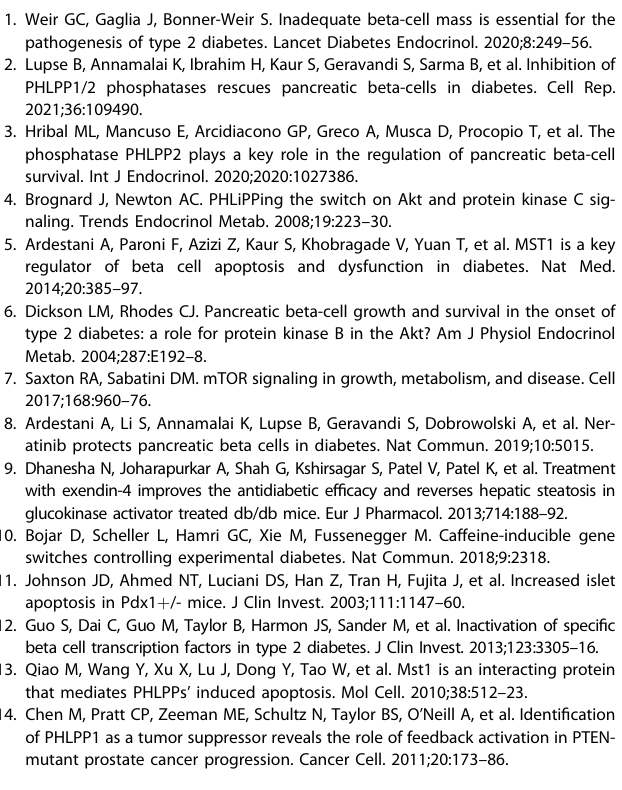
Fig. 2 PHLPP1 depletion promotes β -cell survival in the obese db/db mouse model of type 2 diabetes. A Insulin-positive area and B β -cell mass analysis given as a mean percentage of the entire pancreatic section area from 10 sections/mouse throughout the whole pancreas, C the respective β -cell size analysis from 100 randomly chosen β -cells from each group and D representative insulin staining of the pancreas. E – H Quantitative analyses and representative images of E , F double-staining for TUNEL and G , H triple-staining for Ki67 both expressed as a percentage of insulin-positive β -cells (an average of 3827 and 3965 β -cells/ mouse were counted for TUNEL and Ki67 analyses, respectively for each group). Quantitative analyses ( I , K ) and representative images ( J ) of the percentage of glucagon-positive α -cells (red) and insulin-positive β -cells (green) together with quantitative analyses of insulin and glucagon colocalization ( L ; an average of 1455 β -cells and 529 α -cells/mouse were counted for each group). M , N Representative images for double-staining of M nuclear PDX1 and N GLUT2 expression. Data show means from all pooled analyses for each mouse ± SEM. * p < 0.05 db/db-PHLPP1 − / − vs. db/db-PHLPP1 + / − controls; all by Student ’ s t -tests. Scale bars depict 50 µm in D and 10 µm in F , H , J , M , N